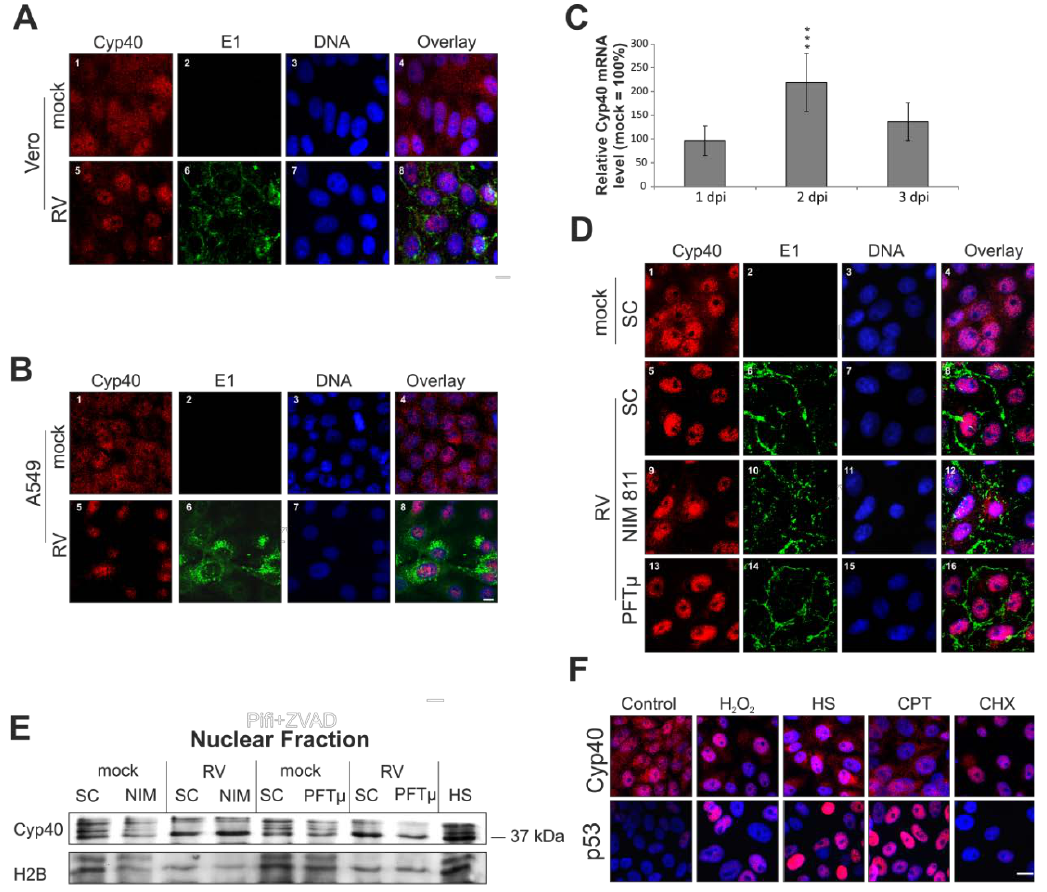
Figure 6. Impact of RV infection on intracellular distribution of cyclophilin 40. ( A ), ( B ), ( D ) and ( F ) Immunofluorescence analysis was performed with anti-Cyp40 (shown in red) antibody to assess intracellular distribution of Cyp40. RV infection was visualized with anti-E1 antibody (shown in green). Nuclear DNA is shown in blue. Pink colour indicates overlap areas. After fixation with 2% ( w / v ) paraformaldehyde, cells were permeabilized with methanol. Intracellular distribution of Cyp40 in mock- and RV-infected ( A ) Vero cells and ( B ) A549 cells at 3 dpi; ( C ) Time course analysis of the mRNA expression level of Cyp40. RNA was extracted at 1, 2, and 3 dpi from RV- and mock-infected Vero cells and subjected to analysis by quantitative real-time PCR; ( D ) Three days after infection with RV in the presence of pharmacological inhibitors (NIM811 (2 μM) at 2 hpi and PFTμ (12,5 μM) at 24 hpi) the intracellular distribution of Cyp40 was compared to the SC; ( E ) Western blot analysis of nuclear fractions obtained from mock- and RV-infected Vero cells. SC is shown in comparison to the incubation with pharmacological inhibitors NIM811 (2 μM) at 2 hpi and PFTμ (12,5 μM) at 24 hpi). Anti-H2B antibody was used as a loading control; ( F ) Intracellular distribution of p53 and Cyp40 after application of various stress stimuli, including application of heat stress (2 h at 43 °C and 24 h at 37 °C), overnight incubation with 0.003% hydrogen peroxide (H 2 O 2 ), 100 μM camptothecin (CPT) and 25 μg/mL cycloheximide (CHX). SC, solvent control; scale bar, 10 μm. * p < 0.05, ** p < 0.01, *** p < 0.001, **** p < 0.0001.